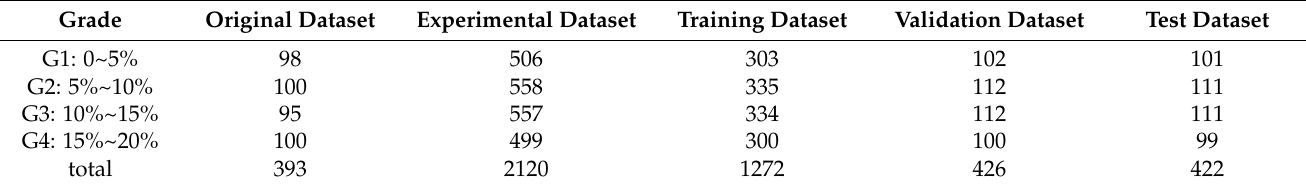
Table 1. Split image dataset distribution and image category based on ore ratio. (G1: group 1, G2: group2, G3: group 3, and G4: group 4).